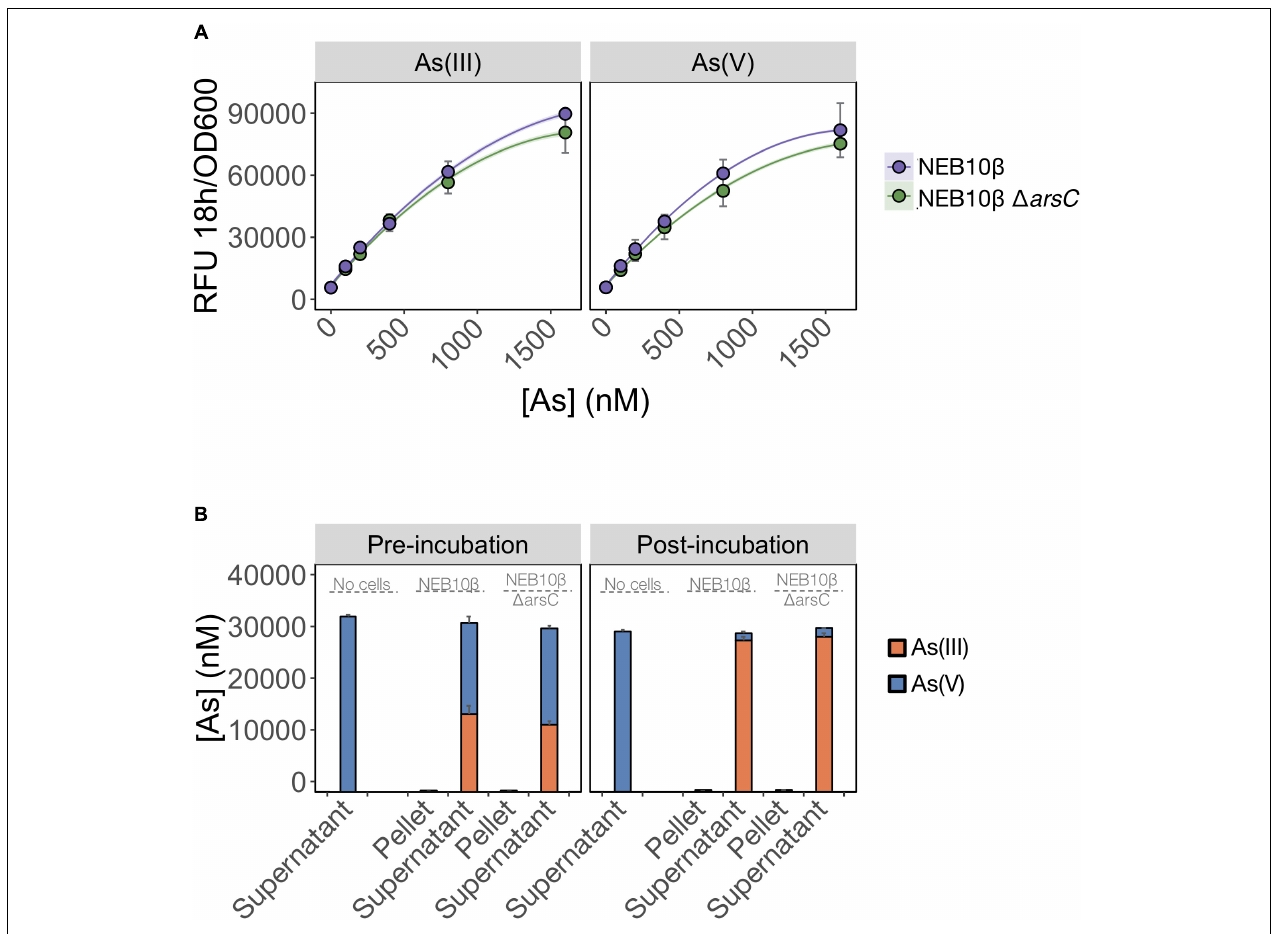
FIGURE 4 | As(V) detection involves an ArsC-independent reduction to As(III). (A) As(III) and As(V) detection by the pMP01 biosensor plasmid was compared for the E. coli host strain (NEB10-beta) and a deletion mutant lacking arsenate specific reductase (NEB10-beta (cid:49) arsC ). Data points represent the mean output signal after 18 h of arsenic exposure in MGP of three independently grown cultures, quantified in triplicate. Error bars indicate standard deviations. We found no significant difference between wild-type and mutant strains ( p = 0.07). (B) Speciation analysis following addition of 32 µ M As(V) to MGP exposure media (no cells), NEB10-beta cultures and NEB10-beta (cid:49) arsC cultures. Treatments were subsampled, fractionated by centrifugation and analyzed before (left panel) and after (right panel) a 3-h incubation. As(III) and As(V) concentrations in pellet and supernatant fractions were quantified using HPLC-ICP-MS. The mean and standard deviation of three independent treatments are